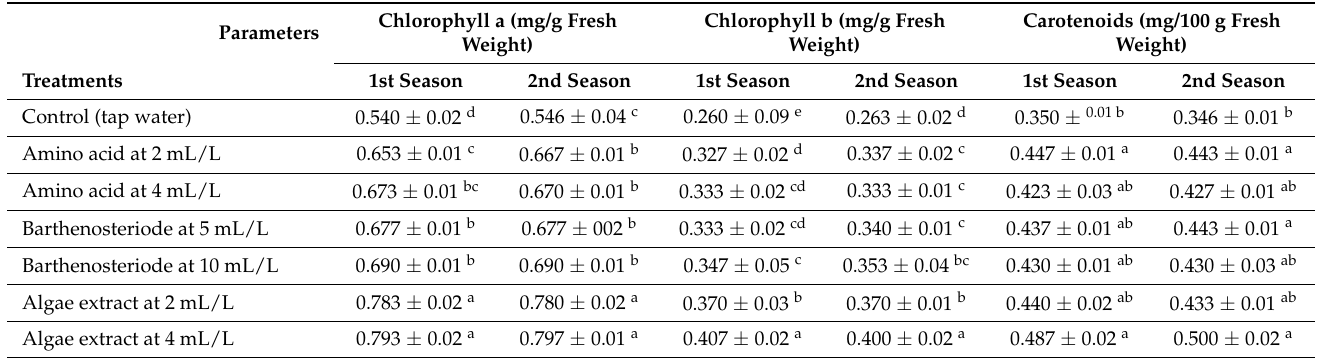
Table 5. Effect of bio-stimulant treatments on chia chlorophyll a, b, and carotenoids during